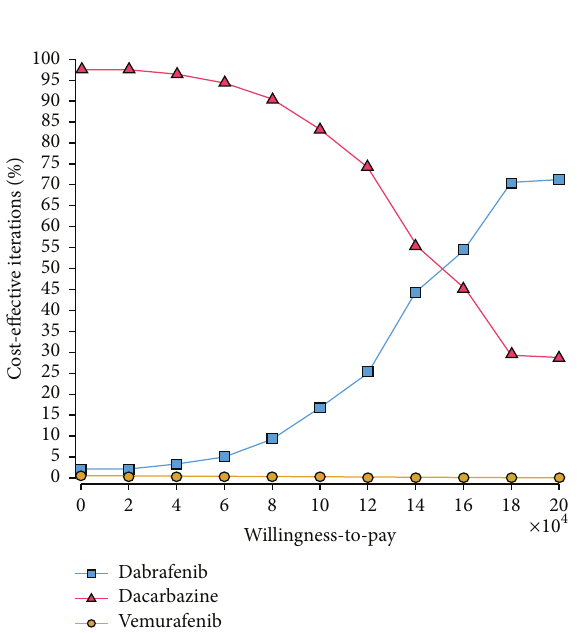
Figure 3: Cost-effectiveness acceptability curve. This acceptability curve shows, for each drug, which percentage of 10,000 Monte Carlo iterations is cost-effective over a range of WTP